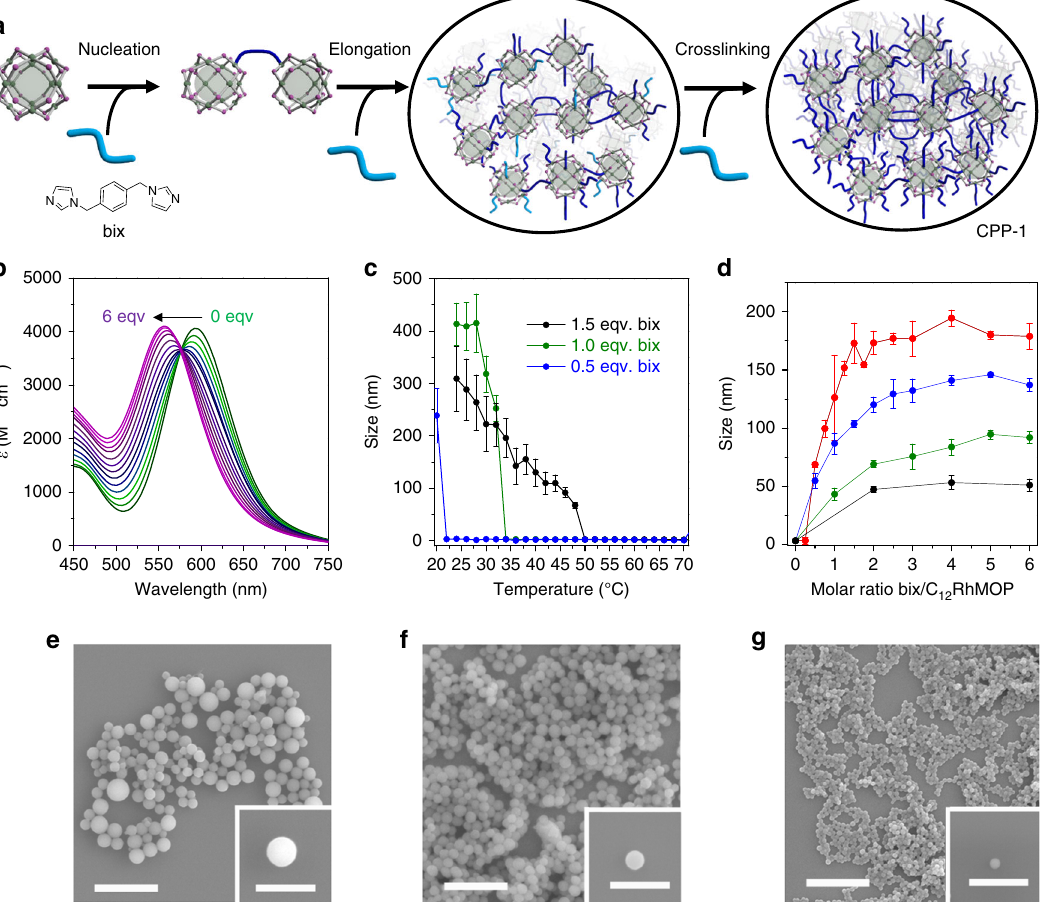
Fig. 3 Stepwise polymerization of C 12 RhMOP leading to coordination polymer particles. a Schematic illustration of the reaction pathway of C 12 RhMOP with bix to yield CPP-1, which entails initial nucleation, followed by elongation upon addition of more bix molecules, and fi nally cross-linking, where the dark blue color of bix represents coordination of both imidazole rings. b UV – vis titration experiment showing the shift in band I of the rhodium paddlewheel in C 12 RhMOP that occurs during the formation of CPP-1, performed using an initial concentration of C 12 RhMOP of 0.23 mM. c DLS monitoring of the size evolution of CPP-1 nuclei (0.23 mM) synthesized after adding 0.5 (blue), 1 (green), and 1.5 mol. eq. (black) of bix at 80 °C and cooling to 20 °C. d Size evolution of the colloids obtained during the titration of C 12 RhMOP (0.93 mM) with bix as determined by DLS measurements. Titrations were performed by adding bix aliquots of 0.25 mol. eq. (red), 0.5 mol. eq. (blue), 1 mol. eq. (green), or 2 mol. eq. (black) at each step. Error bars correspond to the standard deviation of three repetitions. e – g FESEM images of CPP-1 synthesized by adding different amounts of bix (0.25 mol. eq. ( e ), 1 mol. eq. ( f ), and 2 mol. eq. ( g ) up to a molar ratio of bix/C 12 RhMOP = 6. Scale bars: 1 µ m (inset = 500